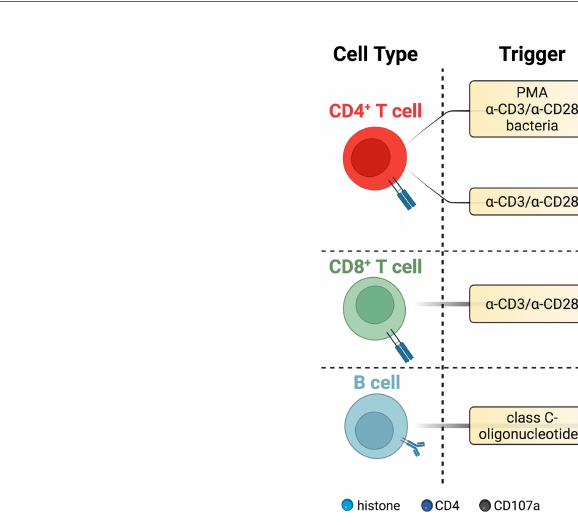
FIGURE 2 | DNA threads released by adaptive immune cells. T cells secrete DNA after activation with polyclonal stimuli such as a -CD3/ a -CD28 antibodies or PMA. These extrusions include thick DNA strands coated with histones reminiscent of ETs or narrow DNA threads dotted with CD4 marker and potentially of mitochondrial origin due to staining with mitochondrial probes MitoTracker and MitoSOX Red. DNA fi bers released by activated CD8+ T cells colocalize with the vesicular marker CD107a. The lytic or vital nature of DNA release from T cells needs further investigation. B cells eject interferogenic mtDNA webs after incubation with class C- oligonucleotides, but these fi bers are not associated with TFAM or antimicrobial proteins. Speci fi c references are given in the body of the text. Created with